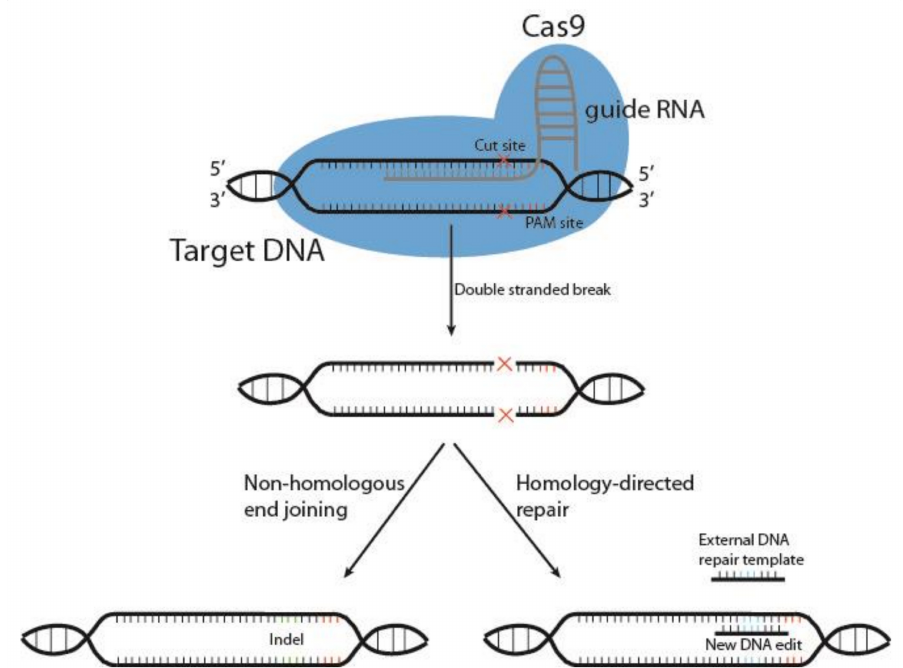
Figure 3. Schematic representation of CRISPR/Cas9 gene editing. The DNA endonuclease Cas9 is introduced to target cells via transduction, transfection or addition of pure Cas9 protein, and complexes with the guide RNA (gRNA). This complex between Cas9 and gRNA searches for a protospacer adjacent motif (PAM) sequence in proximity to the gRNA 20-base sequence. Once bound, Cas9 causes a double-stranded DNA break, and the cell must use either non-homologous end joining or homology-directed repair to fix the break. This results in either wild type DNA, edited DNA, or insertions and deletions (indels) that result in gene